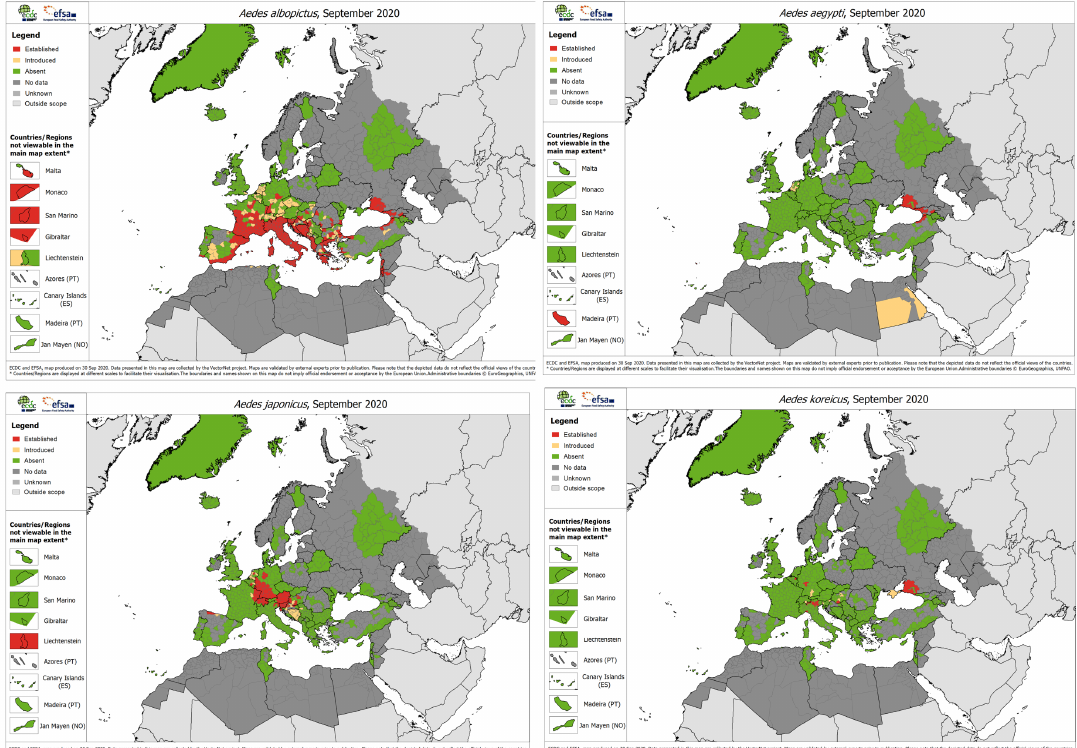
Figure 1. Current known distribution of Aedes invasive species in Europe (September 2020; accessed on 19 November 2020). The maps show the current European distribution of Ae. albopictus (upper-left panel), Ae. aegypti (upper-right panel), Ae. japonicus (lower-left panel) and Ae. koreicus (lower-left panel). European Centre for Disease Prevention and Control and European Food Safety Authority. Mosquito maps (internet). Stockholm: ECDC; 2020. Available from: https://ecdc.europa.eu/en/disease-vectors/surveillance-and-disease-data/mosquito-maps.